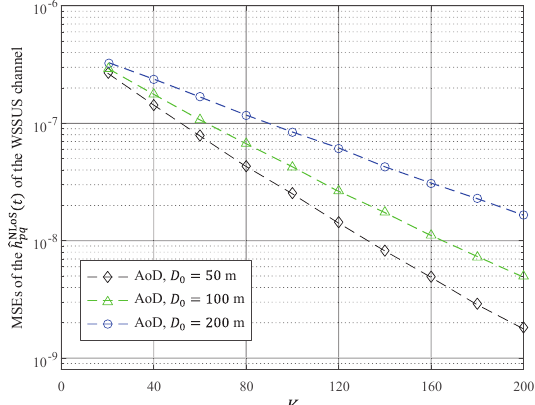
Figure 3. MSEs of the AoD estimations in the WSSUS channel models for V2V communications with respect to the distance D 0 when v T = 10 m/s, v R = 10 m/s, ϕ T = π , and ϕ R = 0.